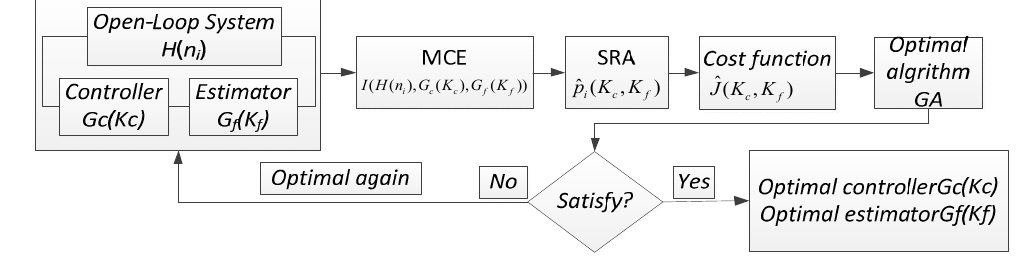
Figure 3. The design flow of SRAD. Table 1. The stability and